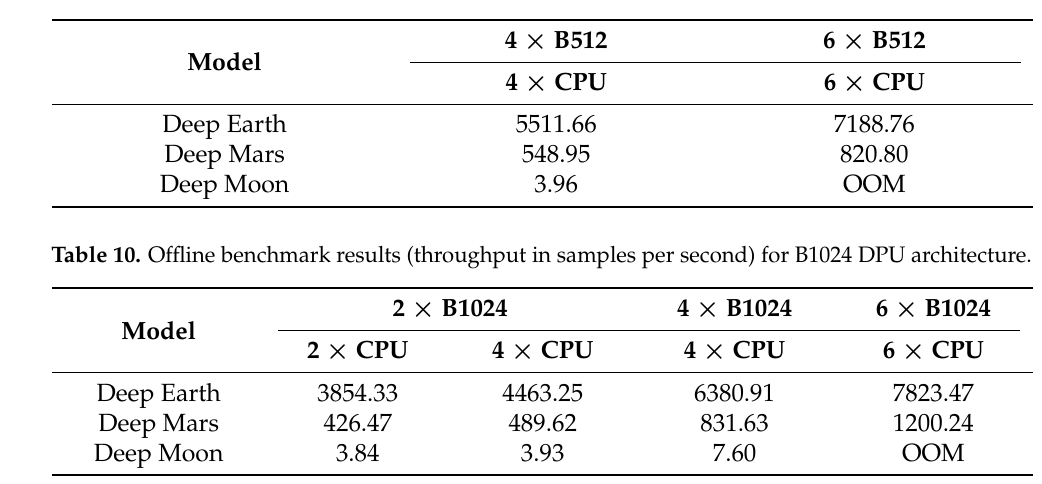
Table 9. Offline benchmark results (throughput in samples per second) for the B512 DPU architecture. Here, OOM denotes out of memory.